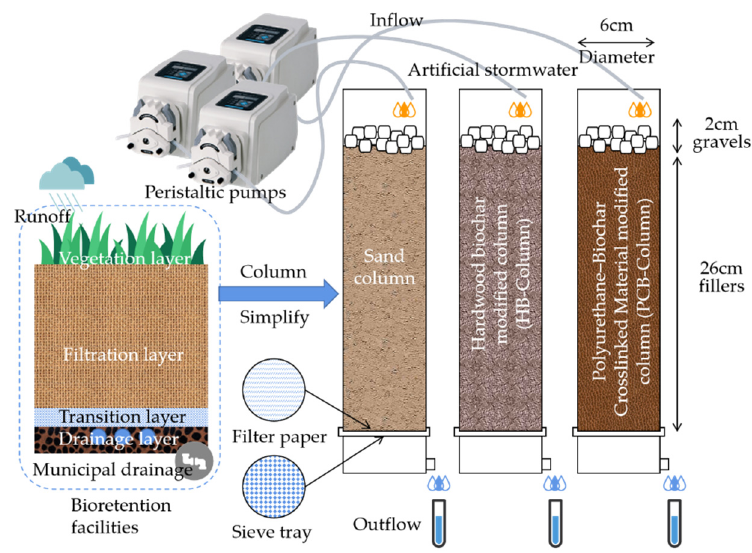
Figure 1. Schematic diagram of column experiments.